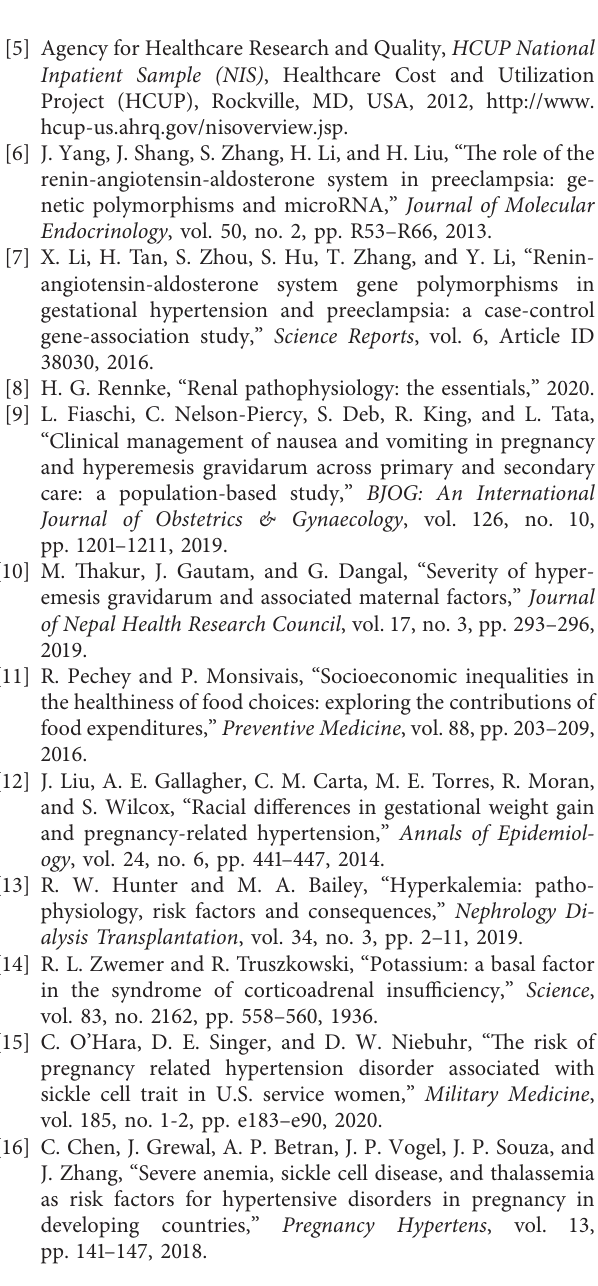
Supplement Table 1: International Classification of Diseases (ICD-9) code for medical conditions. Supplement Table 2: International Classification of Diseases (ICD-9) code for obstetric complications. ( Supplementary Materials )